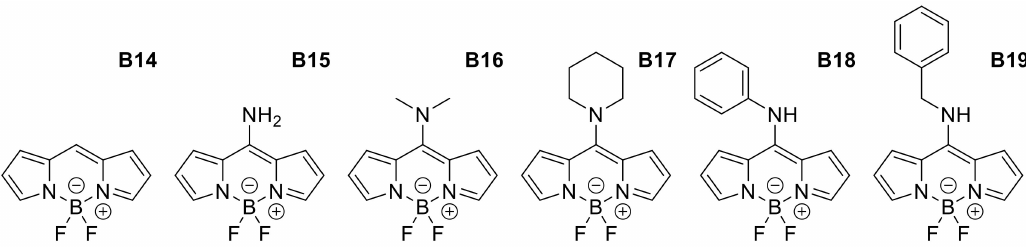
Figure A4. Amino groups placed at the meso position.